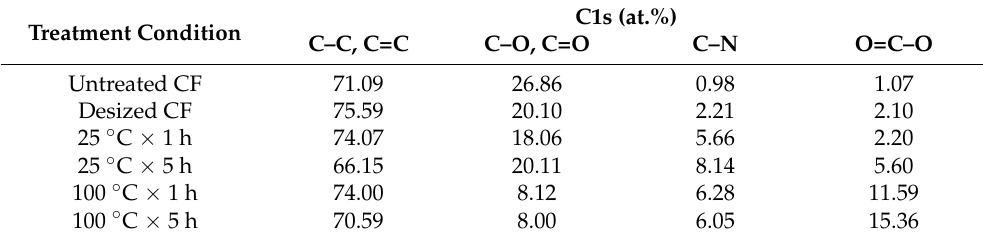
Table 3. Functional group according to temperature and treatment time by